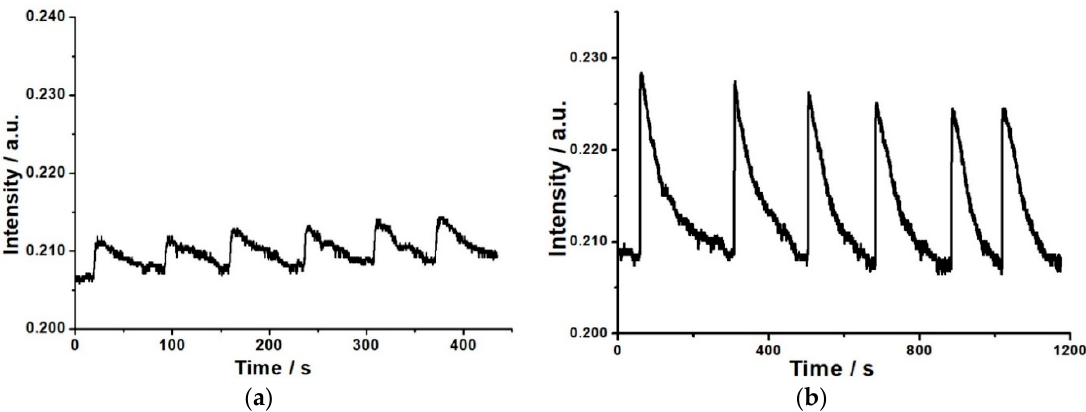
Figure 8. The repeatable response to 0.042 × 10 − 6 ( a ) and 26.32 × 10 − 6 . ( b ) Volume fraction of DCP vapor.